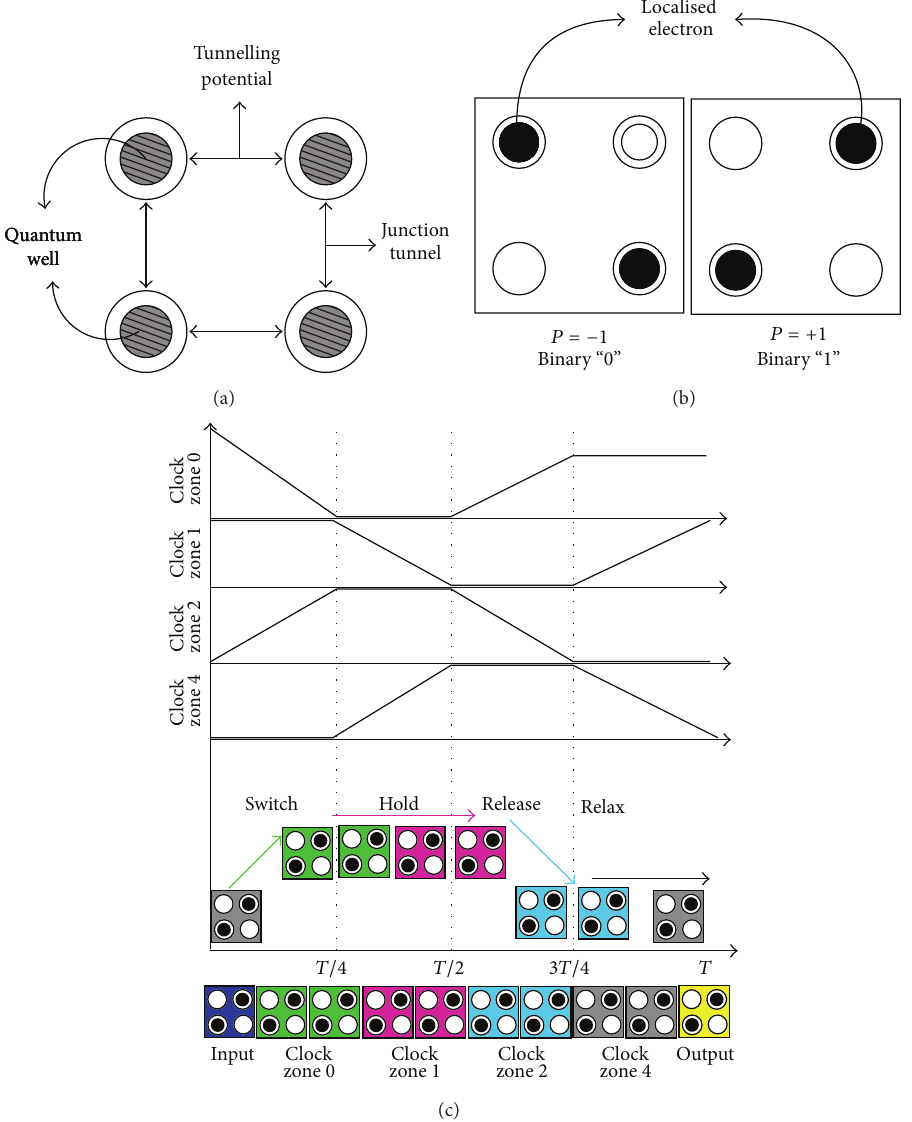
Figure 1: (a) QCA cell and (b) QCA cell with two different polarization. (c)